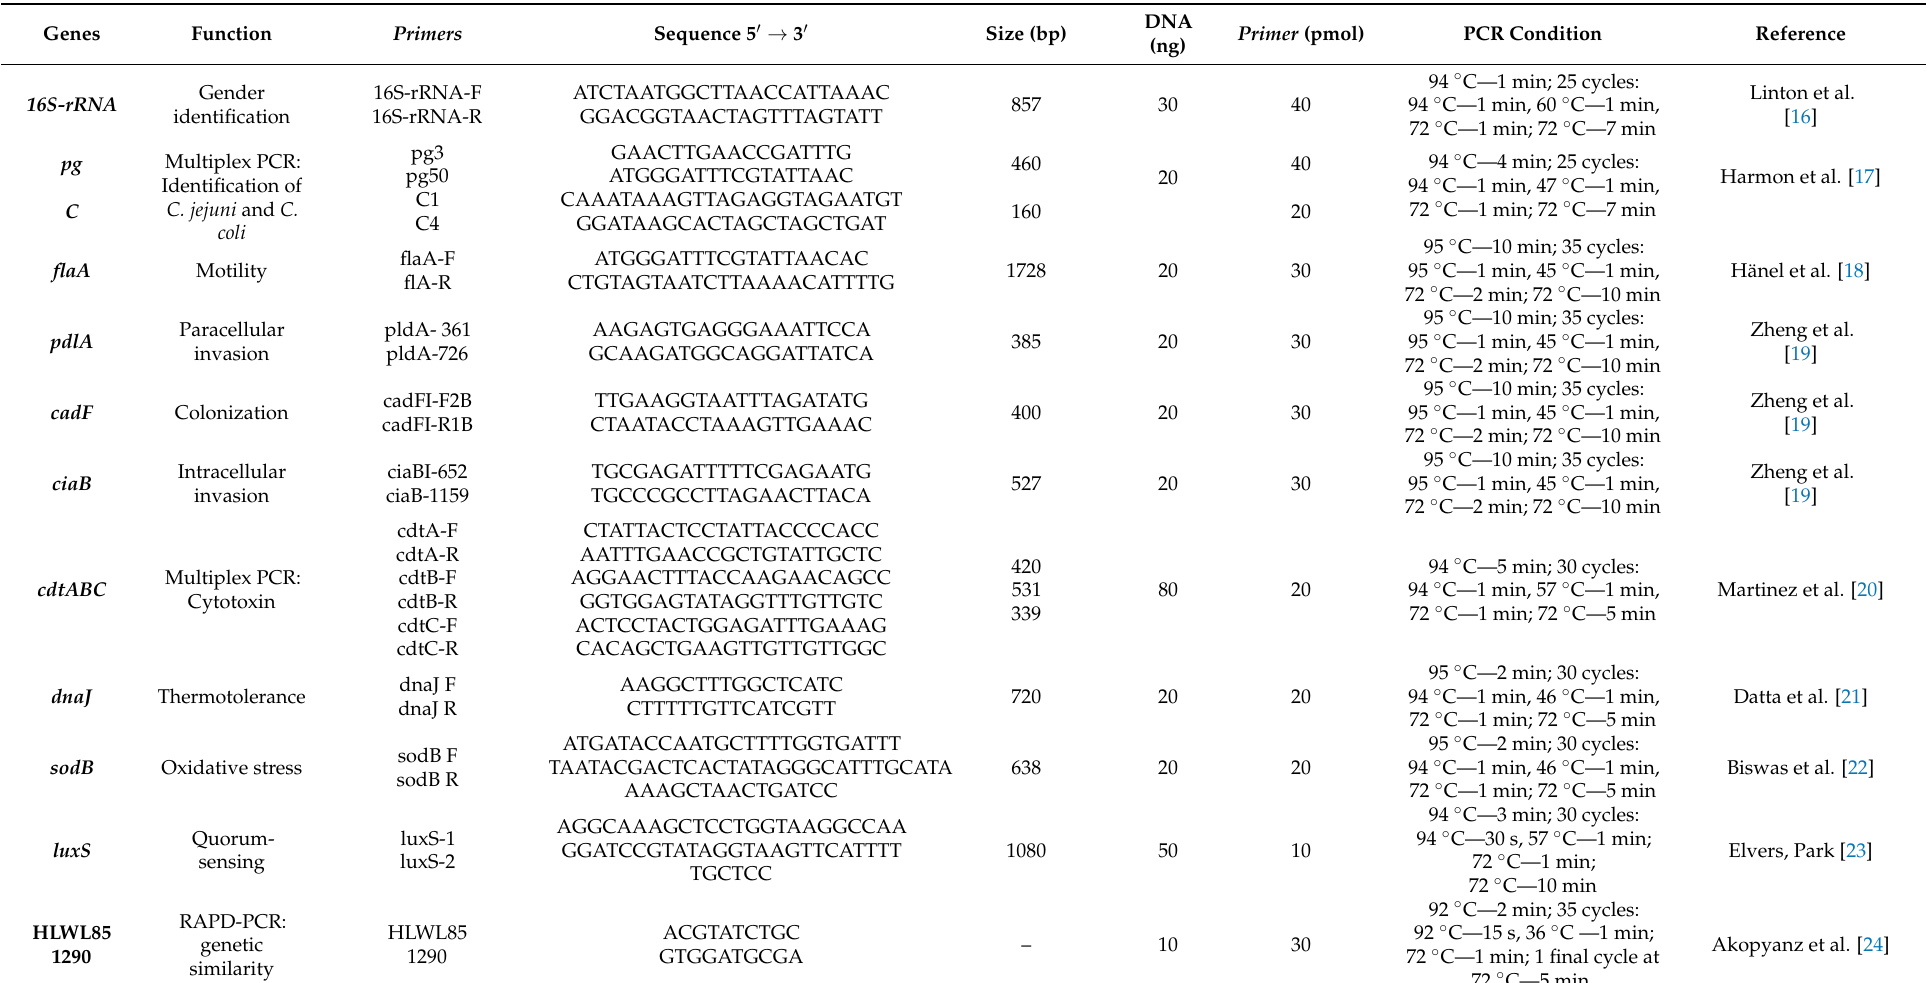
Table 2. Primers , function, amplicon size, PCR conditions, RT-PCR, RAPD-PCR and